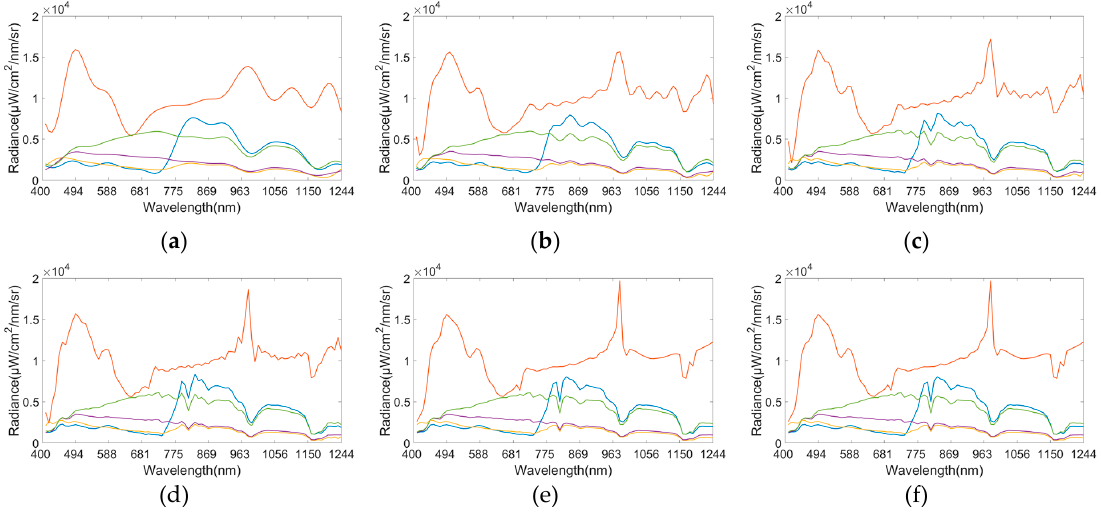
Figure 6. Reconstructed spectral signatures with different values of parameter α . ( a ) α= 0.1 ; ( b ) α= 0.2 ; ( c ) α= 0.3 ; ( d ) α= 0.4 ; ( e ) α= 0.5 ; ( f ) α= 0.6 .